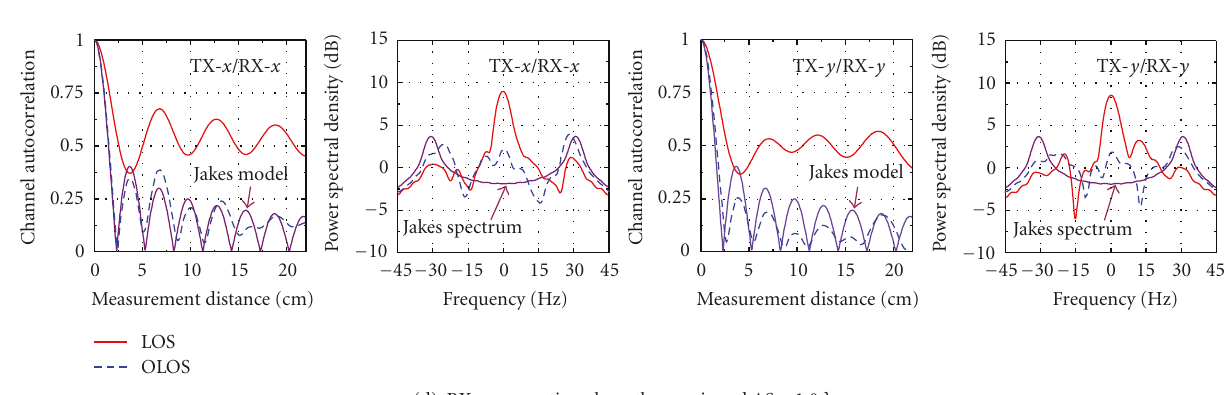
(c) RX array motion along the x -axis and AS = 1.0 λ